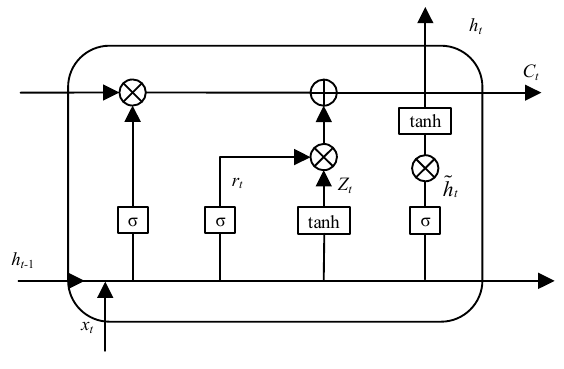
Figure 4. LSTM Figure 4. LSTM model. Figure 4. LSTM model.